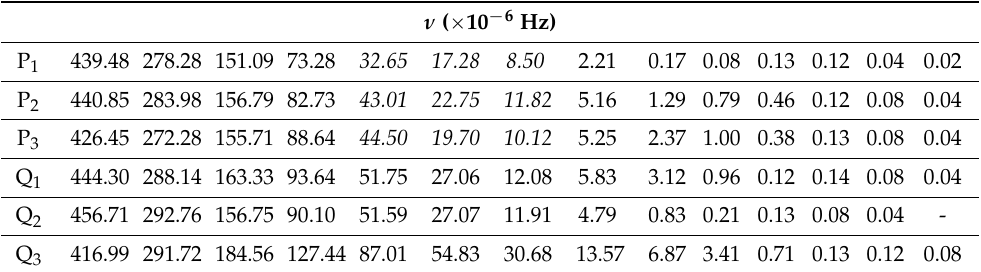
Table 1. Frequencies of the 14 IMFs for L 1 , L 2 and L 3 lines.